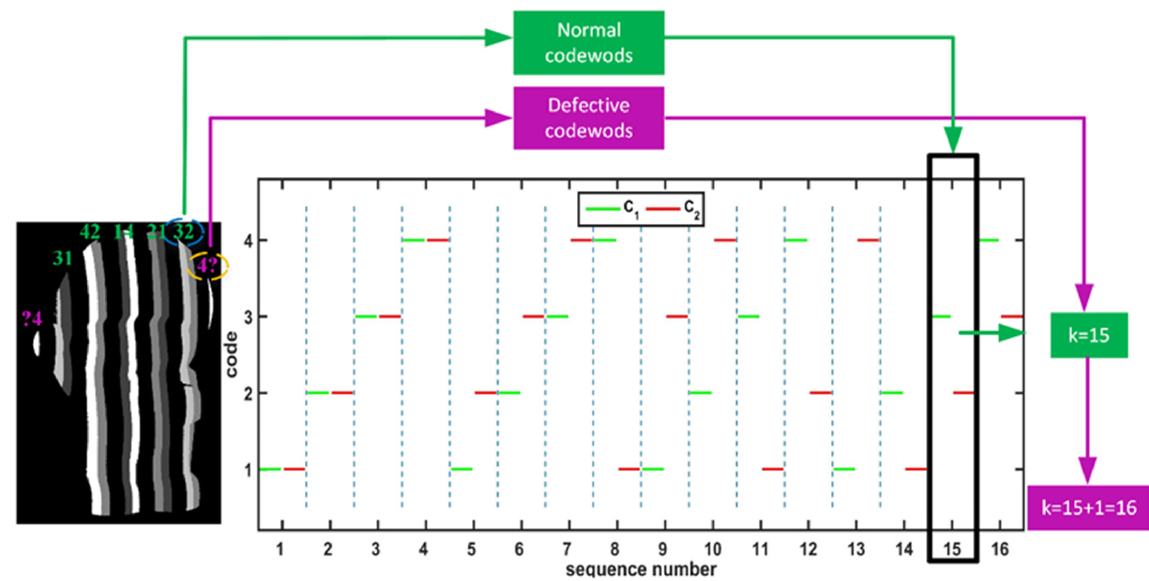
Figure 4. The process of